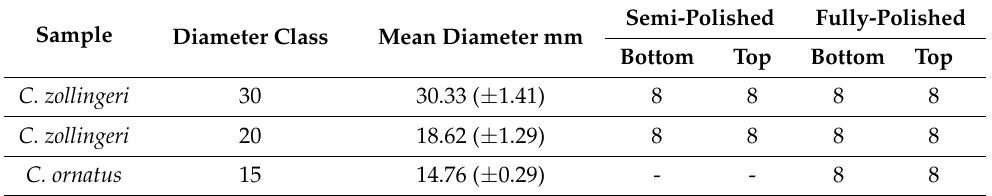
Table 1. Number of samples used per rattan species and diameter classes. Values in parentheses are standard